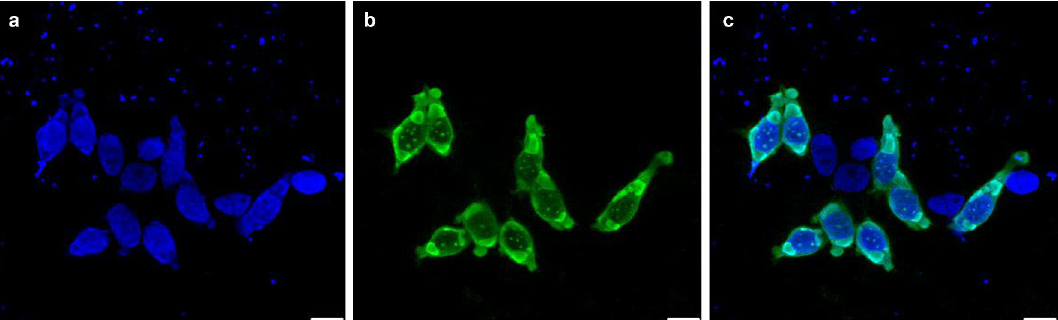
Figure 1. Cytoplasmic localization of expressed CCHFV NP. HEK293T cells transfected with the CCHFV NP-expressing plasmid were stained with DAPI (shown in blue) ( a ) and the rabbit antiserum to CCHFV NP